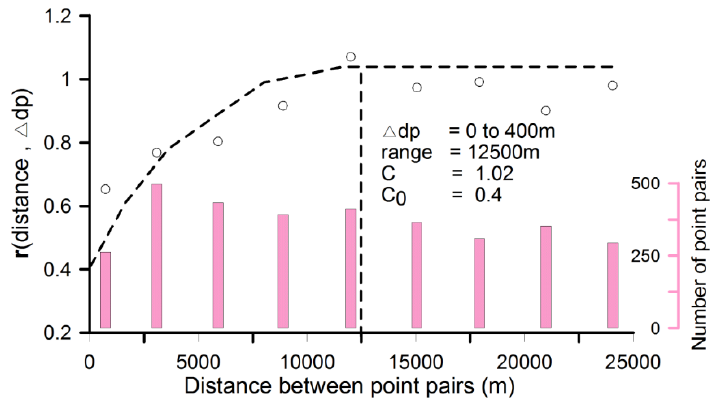
Figure 5. Experimental distance/relative-depth-based variogram for unified data (264 surveying samples, shown in Table 1) from multiple seamounts, with a relative-depth interval of 0–400 m. When interpolating using this variogram via kriging, the information point search was restricted to Δ dp ≤ 400 m. The dotted curve exhibits effectiveness of the experimental variogram at describing the spatial self- correlation and the continuity of mineral resources in terms of cobalt-rich crust thicknesses on seamounts in such a depth interval.